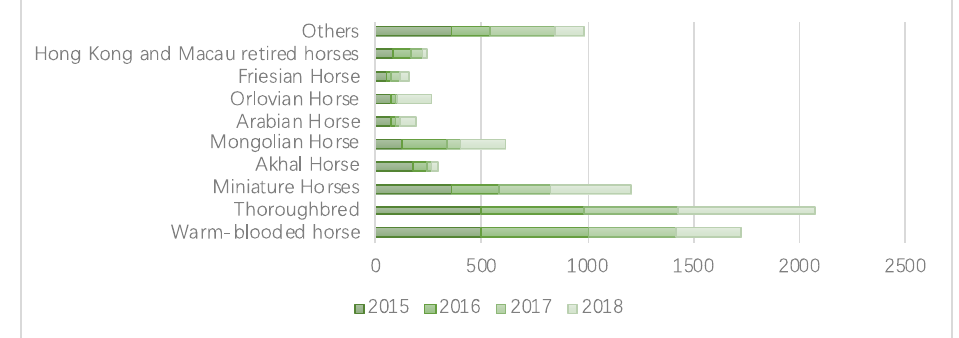
Figure 4. The proportion of imported horse breeds, data from [19].